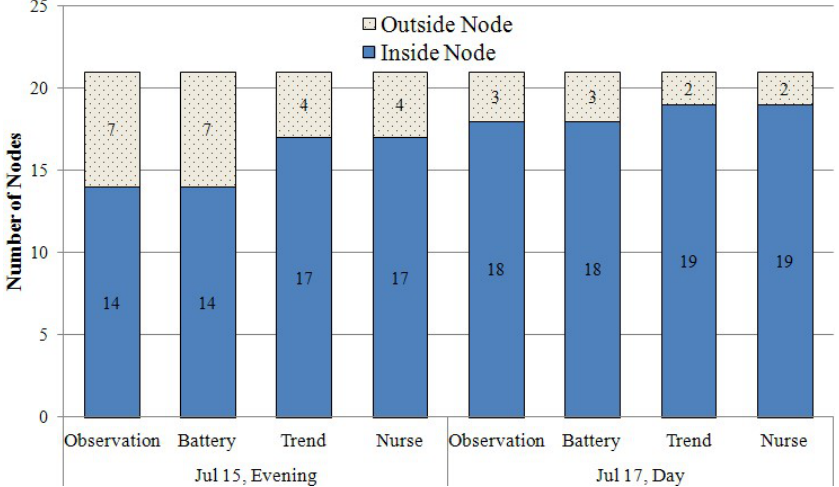
Figure 8. Detection results of the number of inside and outside nodes for real data generated in the emergency room [17]. (With the permission of IEEE